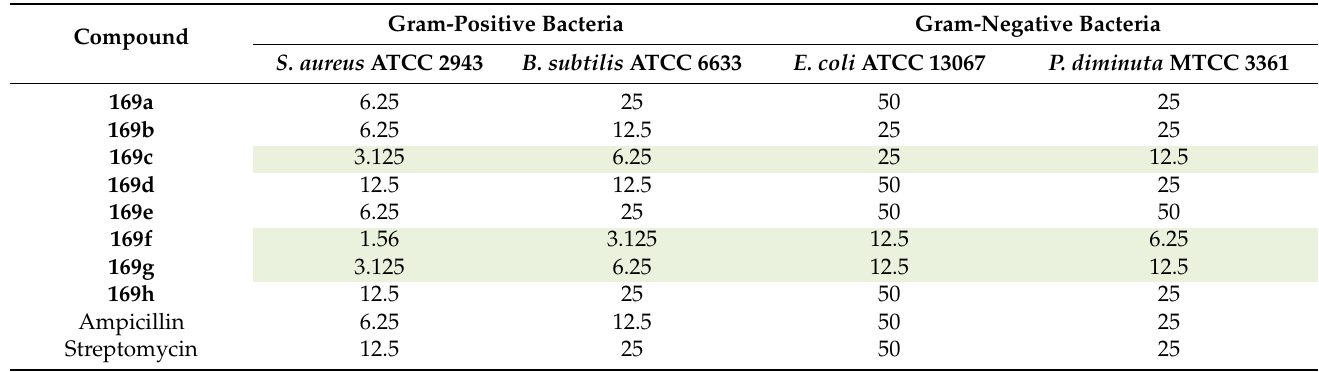
Table 11. MIC values (in µg mL − 1 ) of oxazolo[4,5-b]pyridine derivatives 169a − 169h [72].